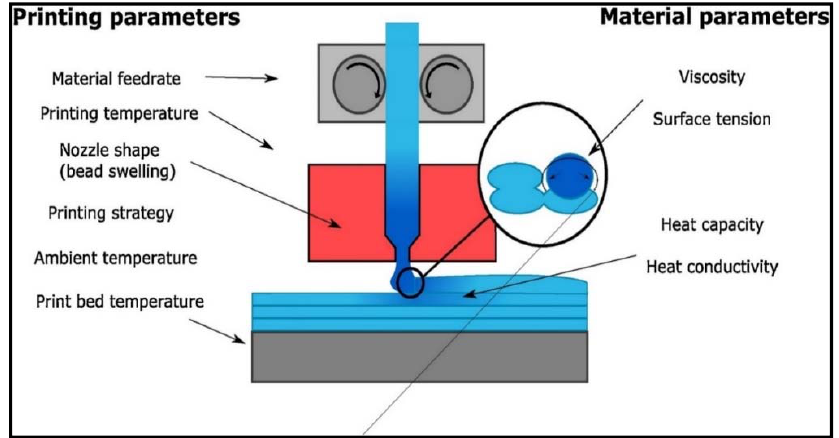
Figure 21. Influencing parameters to attain best possible sintering between different polymer